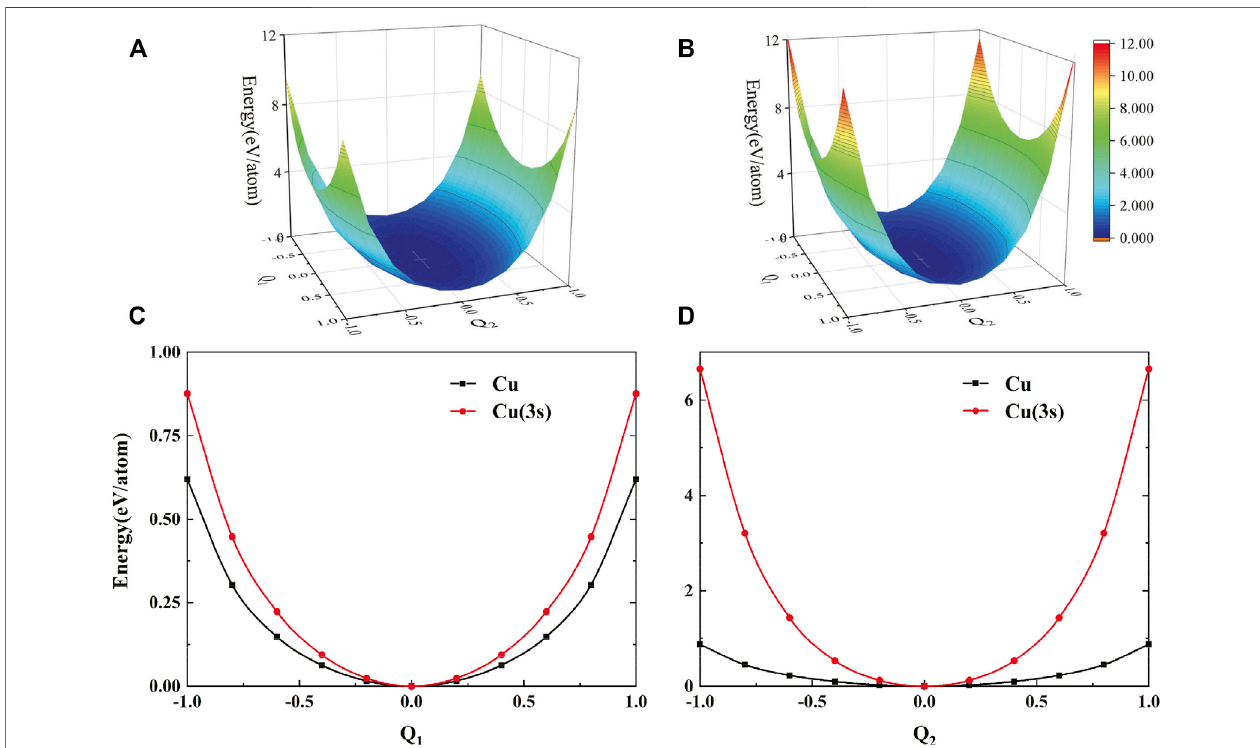
FIGURE 5 | PES of Cu in the direction of the eigenvectors at high-symmetry point L. Q 1 and Q 2 correspond to dimensionless normal coordinates of the lowest TA mode and LA mode without (A) and with (B) a hole in the 3s orbital, respectively. (C) PES along the Q 1 direction with Q 2 = 0. (D) PES along the Q 2 direction with Q 1 = 0. The lattice energy is set as zero in the equilibrium